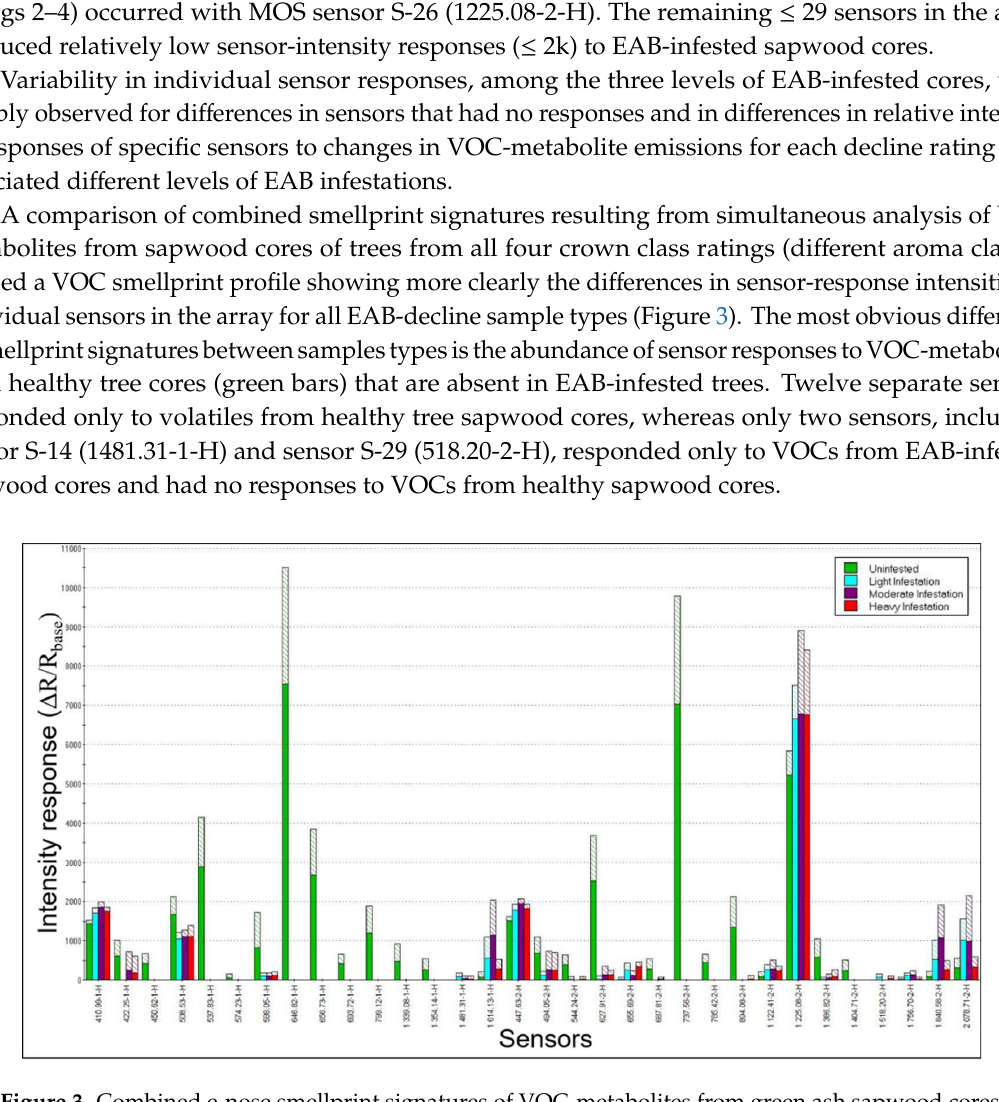
Figure 3. Combined e-nose smellprint signatures of VOC-metabolites from green ash sapwood cores with different levels of EAB infestation. Smellprint signatures patterns derived from the 32-sensor array responses to: (1) Healthy (uninfested) sapwood (decline rating 1, green bars); (2) light EAB-infestation level (decline rating 2, cyan bars); (3) moderate EAB-infestation level (decline rating 3, magenta bars); (4) heavy EAB-infestation level (decline rating 4, red bars). Shaded areas indicate one standard deviation from the mean.